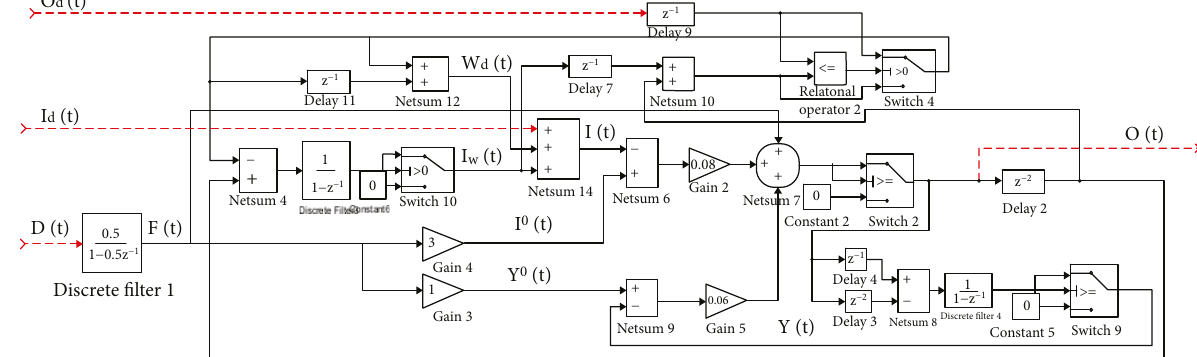
Figure 1: The block diagram of the inventory system of warehouse.